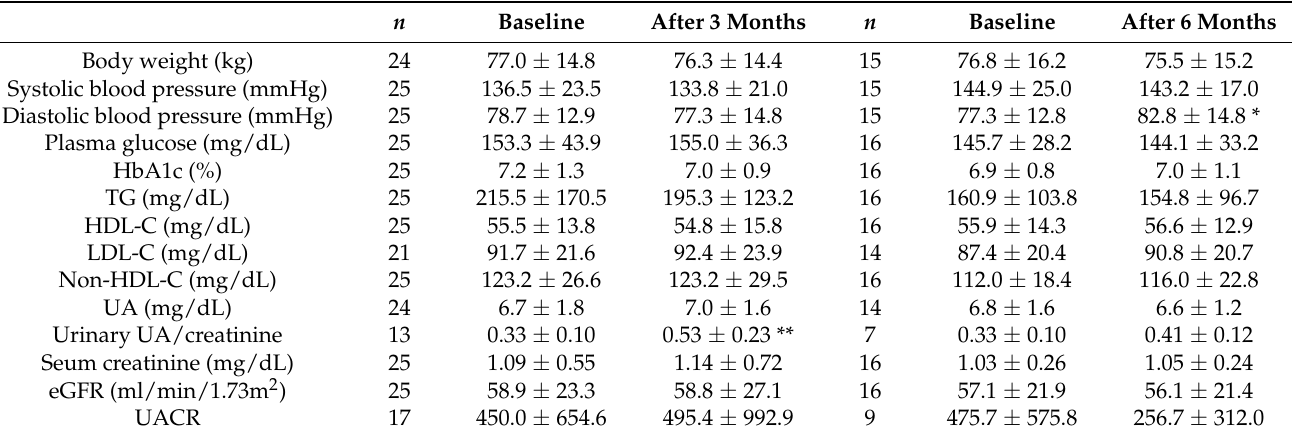
Table 10. Changes in metabolic parameters after the start of dotinurad in patients who had taken SGLT2 inhibitors ( n = 25). n Baseline After 3 Months n Baseline After 6 Months